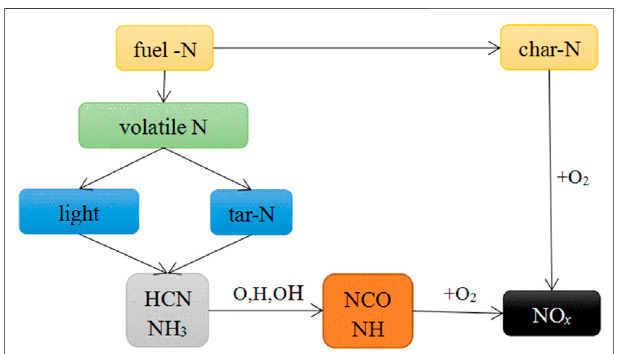
FIGURE 2 | The pathways for conversion of fuel-N into NO x